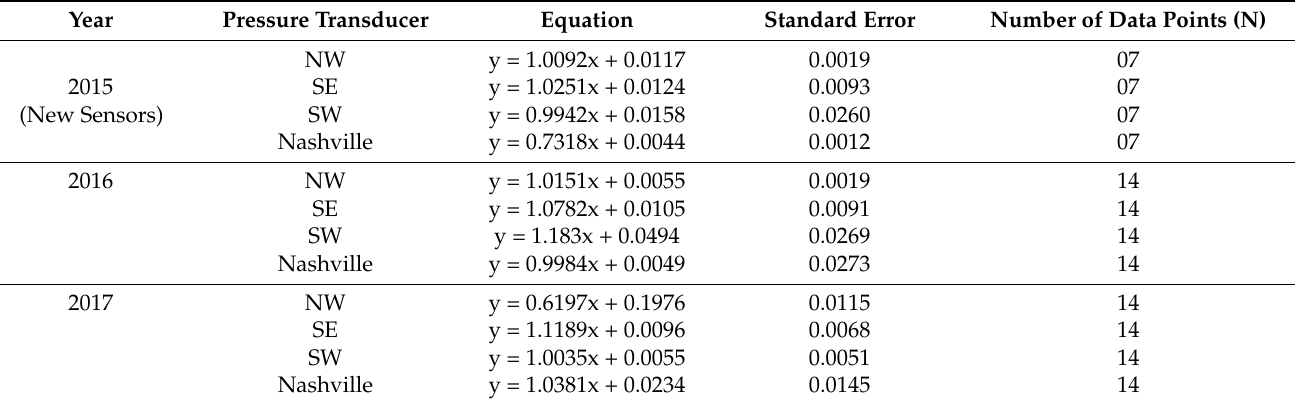
Figure 2. Curbcut inlet fitted with flume and pressure transducer for flow measurement. The pressure transducers were initially factory calibrated, but their logged data were periodically verified against manually surveyed data in the field. The relationship between observed and sensor recorded flow depths was represented by a linear equation y = mx + b, where y is the actual water depth and x is the corresponding depth recorded by the pressure transducer. The standard error of these equations in reproducing the full set of calibration data was then computed (Table 3). Table 3. Calibration curves for all pressure transducers used to measure water